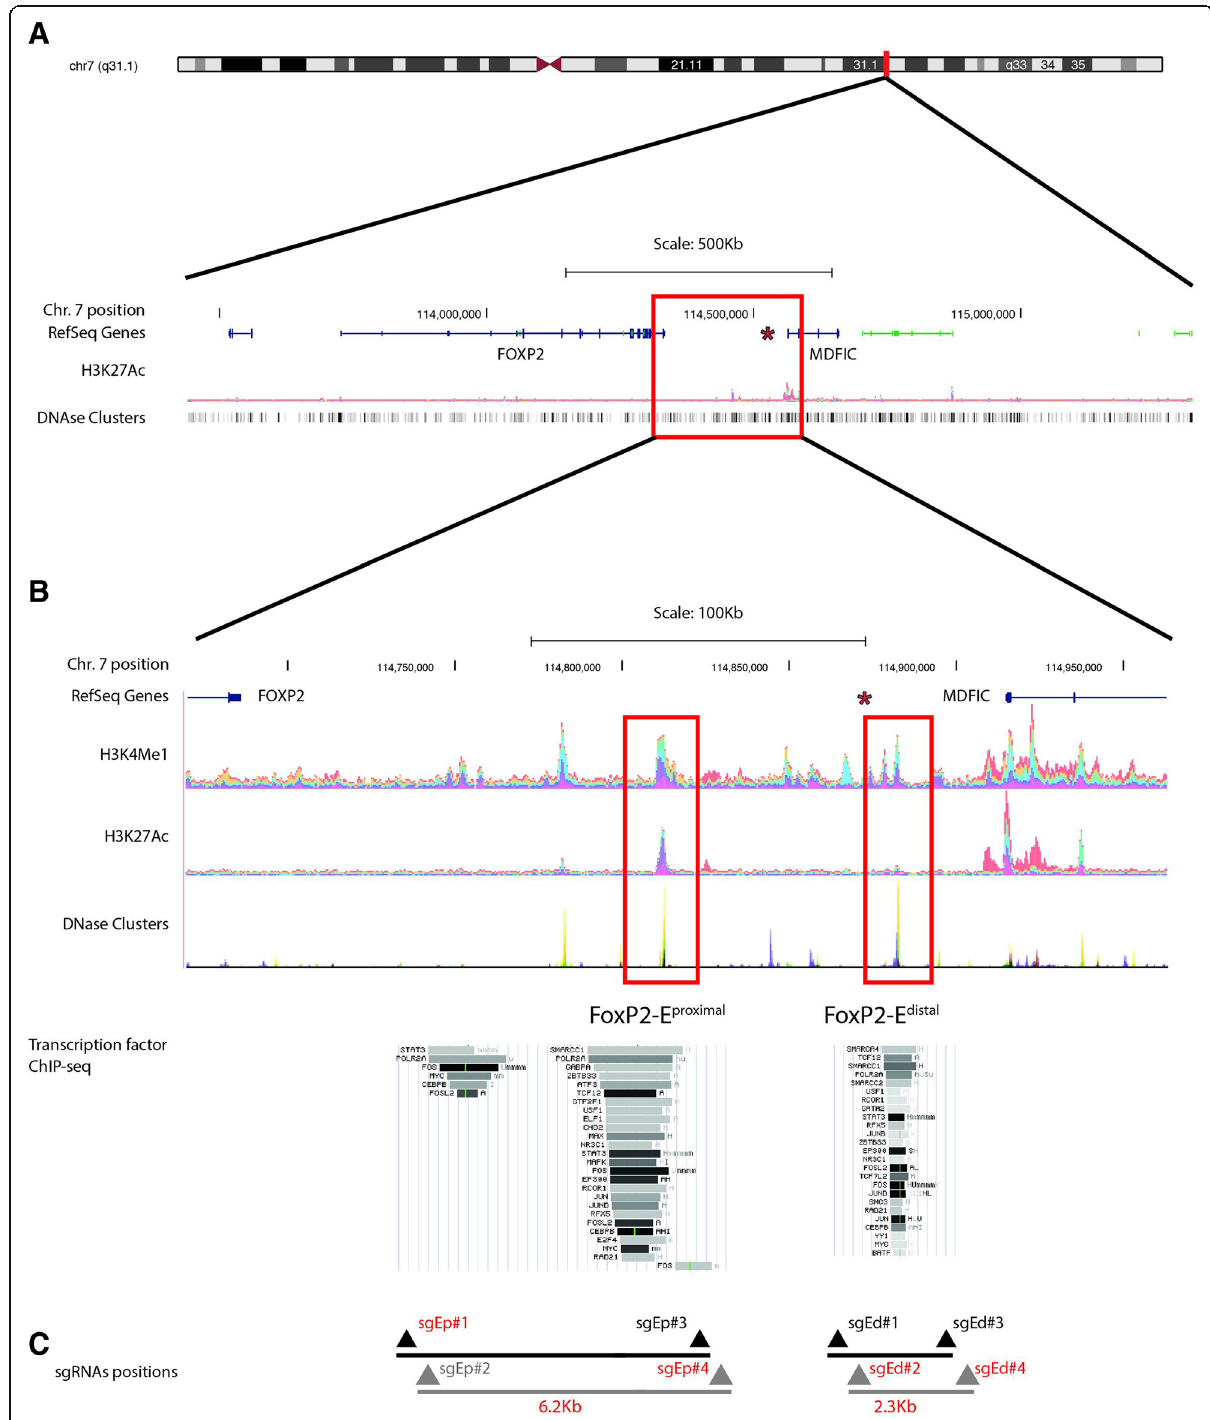
Fig. 1 (See legend on next